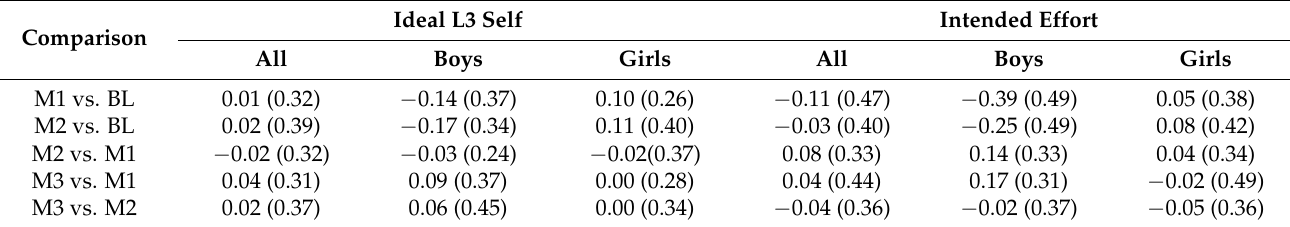
Table 5. Means and SD for gain scores of ideal L3 self and intended effort according to Gender. Ideal L3 Self Intended Effort Comparison All Boys Girls All